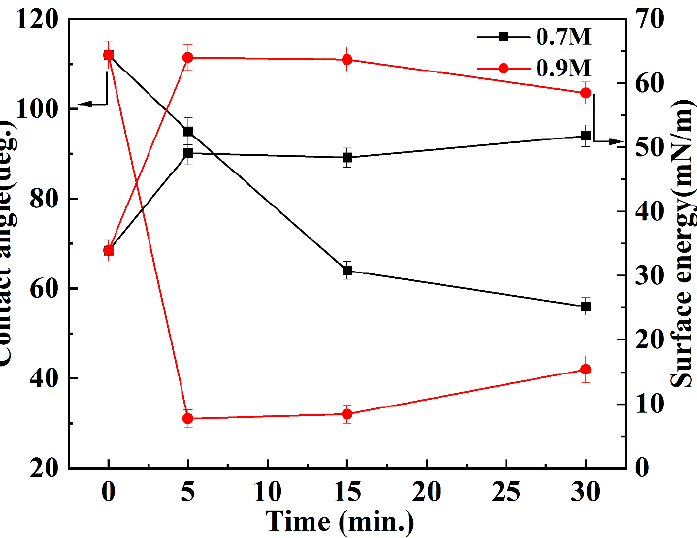
Figure 9. The variation trend of the contact angle and surface energy of FEP films with the activation time in the sodium naphthalene-DMI solution.